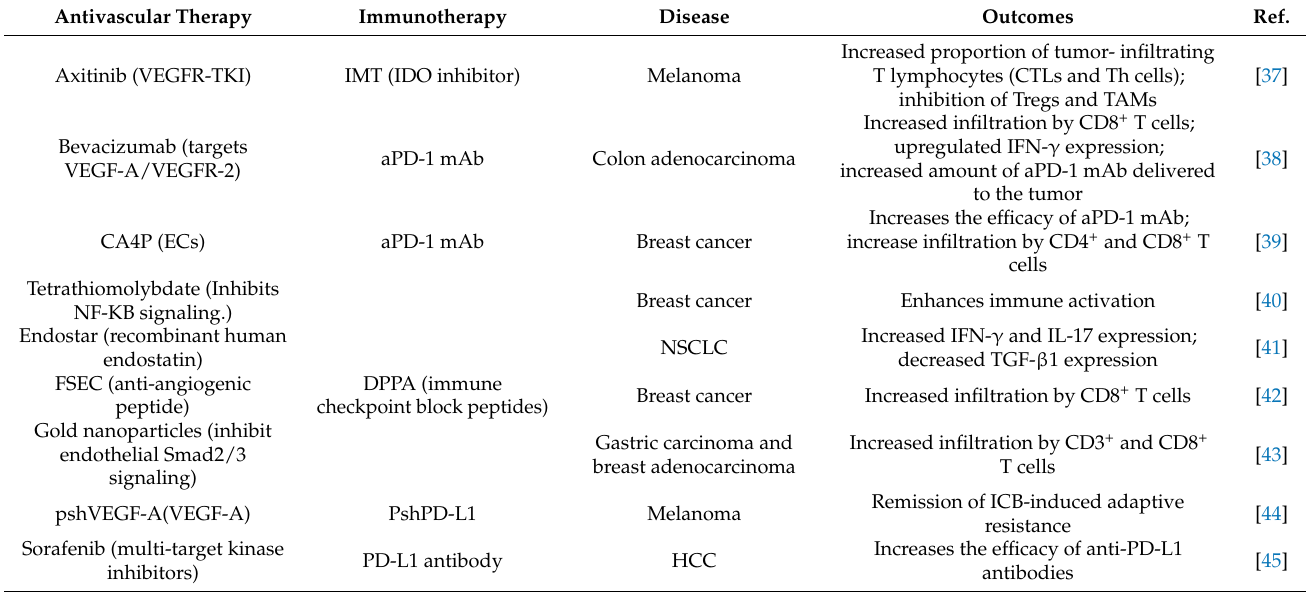
Table 1. Combined therapeutic paradigms of antivascular therapy and